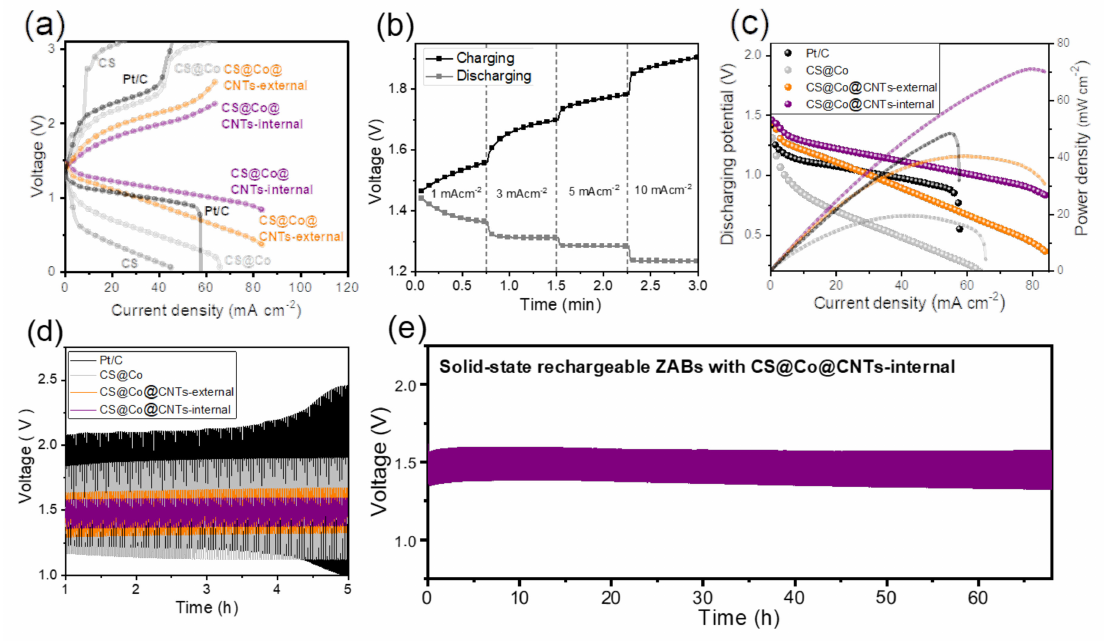
Figure 6. ( a ) Charge-discharge polarization curves of ZABs, ( b ) galvanostatic charge-discharge curves of ZAB with CS@Co@CNTs-internal air cathode at the different current densities. ( c ) The discharge polarization and power density curves. ( d ) Cyclic performance of ZABs. ( e ) Long-term cyclic performance of ZABs with CS@Co@CNTs-internal air